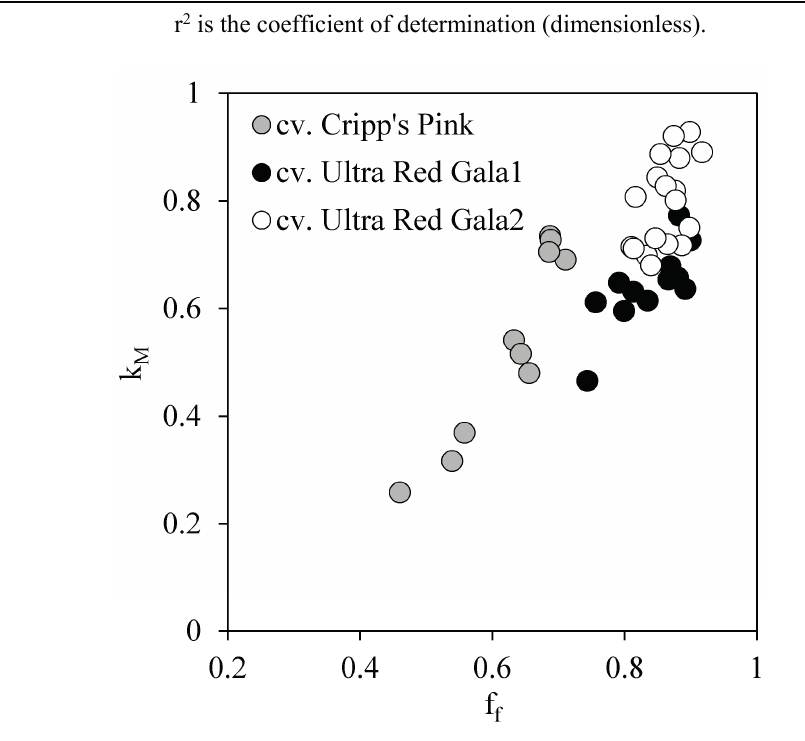
Figure 2. Exponential relationship between measured light extinction coefficient (k M ) and fraction of foliage cover (f f ). Dashed line represents the exponential model for the whole dataset, the continuous line represents the exponential model for the Trial 1 (cv. Cripp’s Pink) and dotted line represents the exponential model for the Trial 2 (cv. Ultra Red Gala 1 and cv. Ultra Red Gala 2